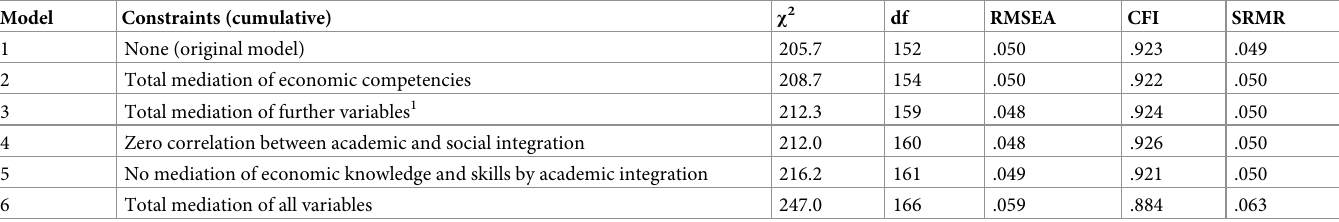
Table 11. Test of different models nested in the original